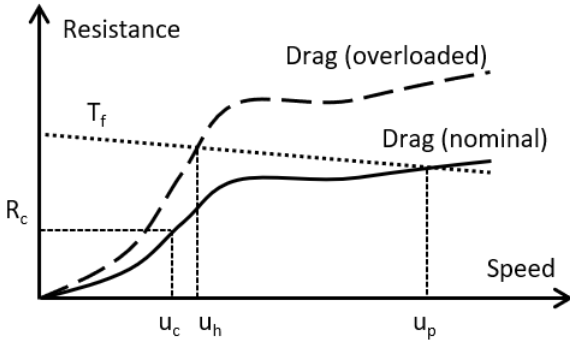
Figure 1. Typical resistance curves of nominal-weight hull (solid line) and overloaded hard-chine hull (dashed line). Approximate full thrust curve is indicated by dotted line. Symbols are explained in the text.